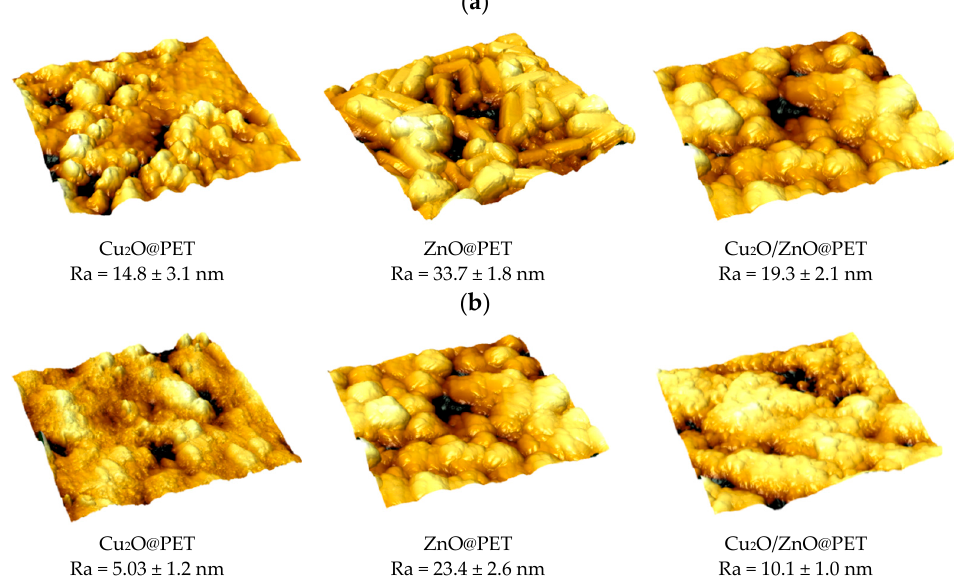
Figure 13. Atomic force microscopy (AFM) images of the surfaces of composite catalysts before ( a ) and after the 4th run of the catalyst treatment ( b ), with a scanning area of 3 × 3 μ m 2.